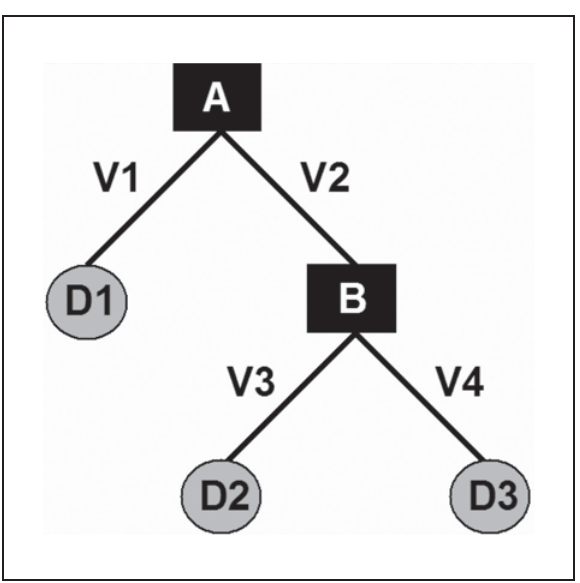
Figura 1 – Modelo esquemático de uma árvore de decisão. A e B (retângulos): nós; V1, V2, V3 e V4 (traços): ramos; D1, D2 e D3 (círculos): folhas; regras diagnósticas: A = V1 implica em D1; A = V2 e B = V3 implicam em D2 e A = V2 e B = V4 implicam em